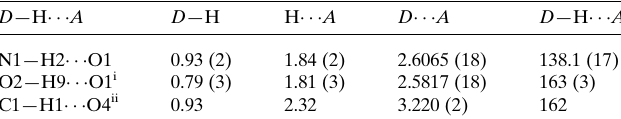
Table 1 Hydrogen-bond geometry (A˚ , (cid:2)